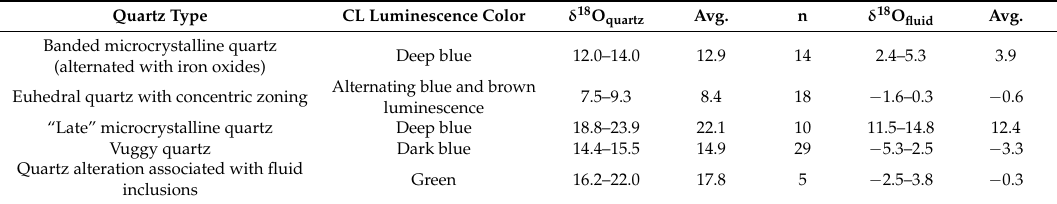
◦ C was used for quartz generations of the QB (lines 1–3 of